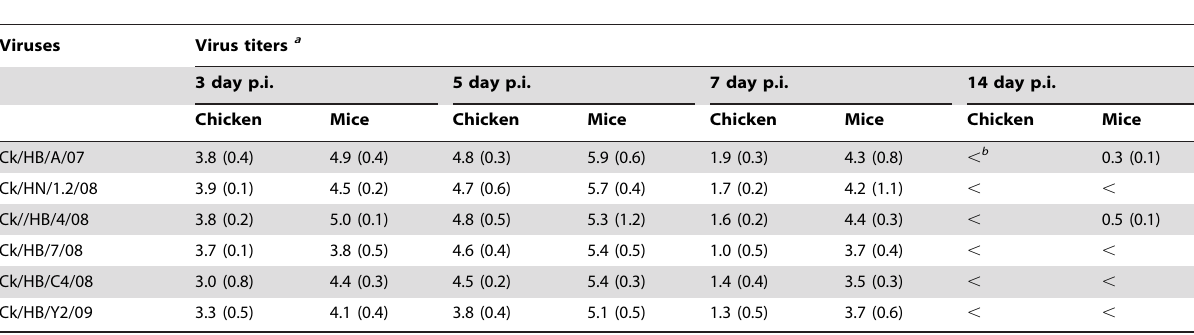
Table 2. Replication of H9N2 viruses in lungs of mice and chickens.